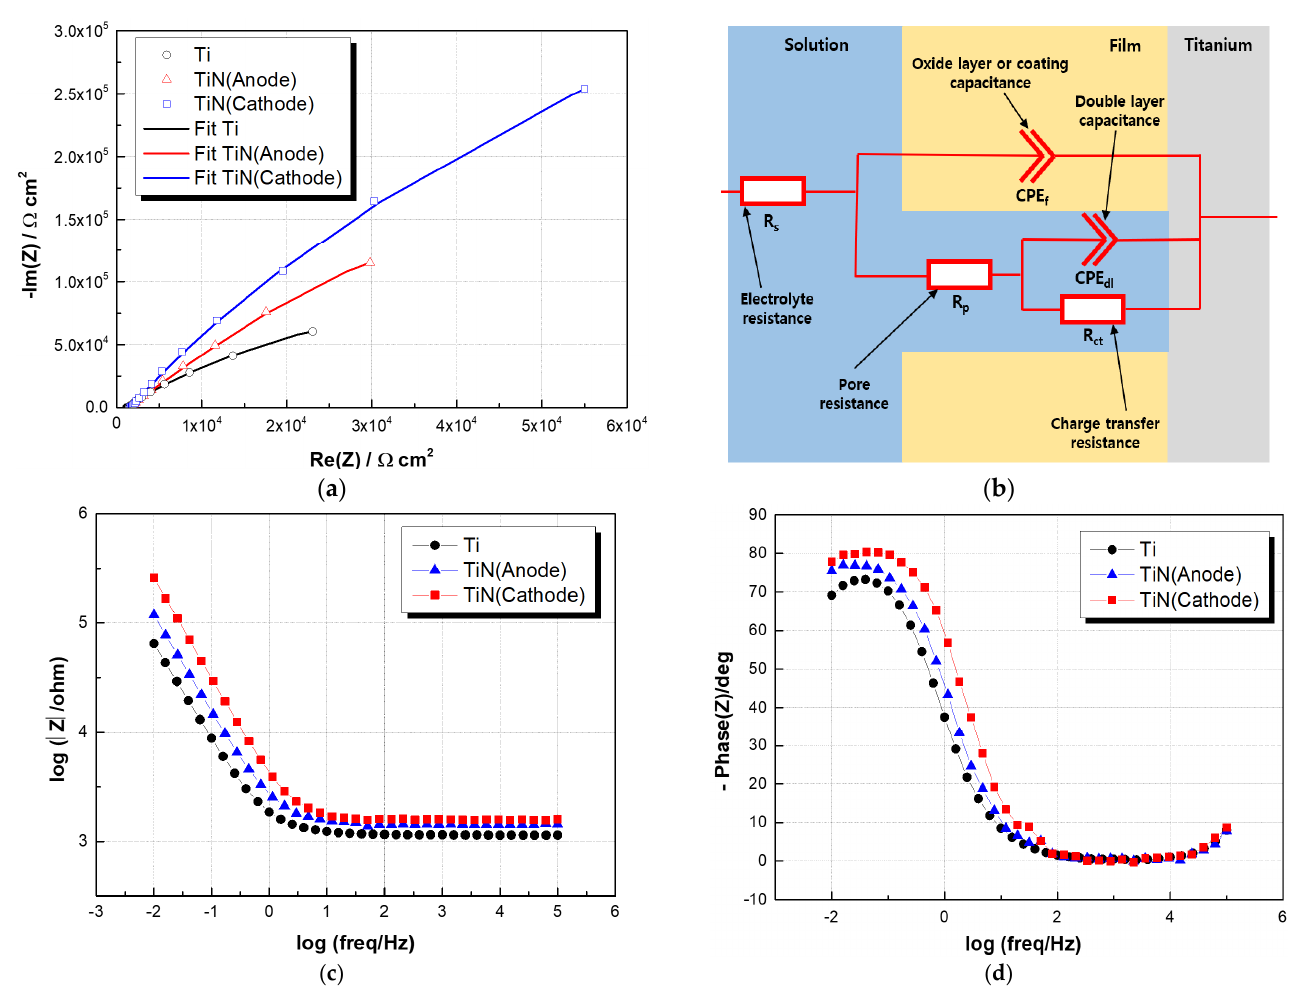
Figure 7. Nyquist plot, bode plots, and equivalent circuit of titanium substrate and TiN-coated specimen in a simulated PEMFC environment. ( a ) Nyquist plot ( b ) Equivalent circuit ( c ) Bode impedance ( d ) Bode phase angle. Table 5. Fitting parameters of titanium substrate and TiN-coated specimen obtained from Nyquist plot.